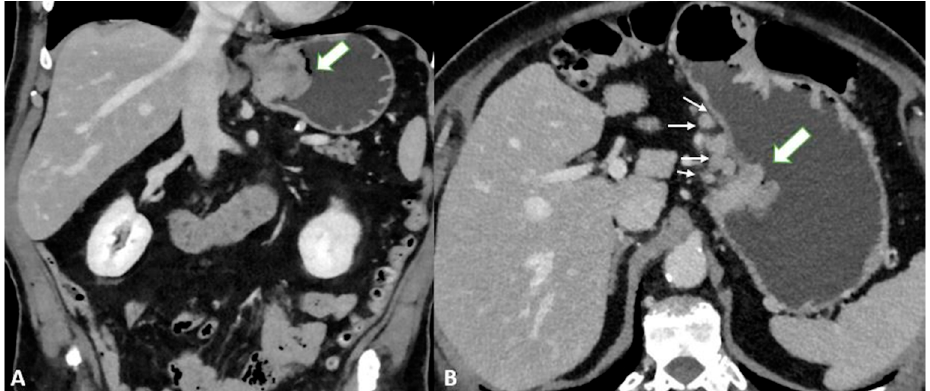
Figure 3. T3 gastric cancer in a 74-year-old female patient. ( A ) Coronal 2D reconstruction in the portal venous phase and ( B ) Axial 2D image showing (thick arrows) enhanced wall thickening in the lesser curvature side of the high body of the stomach. ( B ) also shows a cluster of pathologic round lymph nodes adjacent to the gastric cancer (thin arrows). The tumor invades the subserosa layer without invasion of the serosa and adjacent structures.